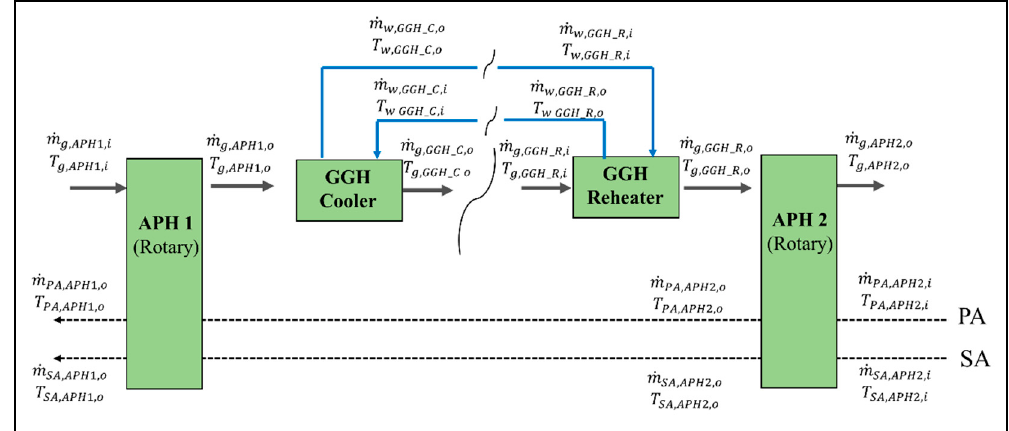
Figure A2. Material flows of the flue gas, air, and water of the APH 1, GGH_C, GGH_R, and APH 2 in the post-gas flow system.